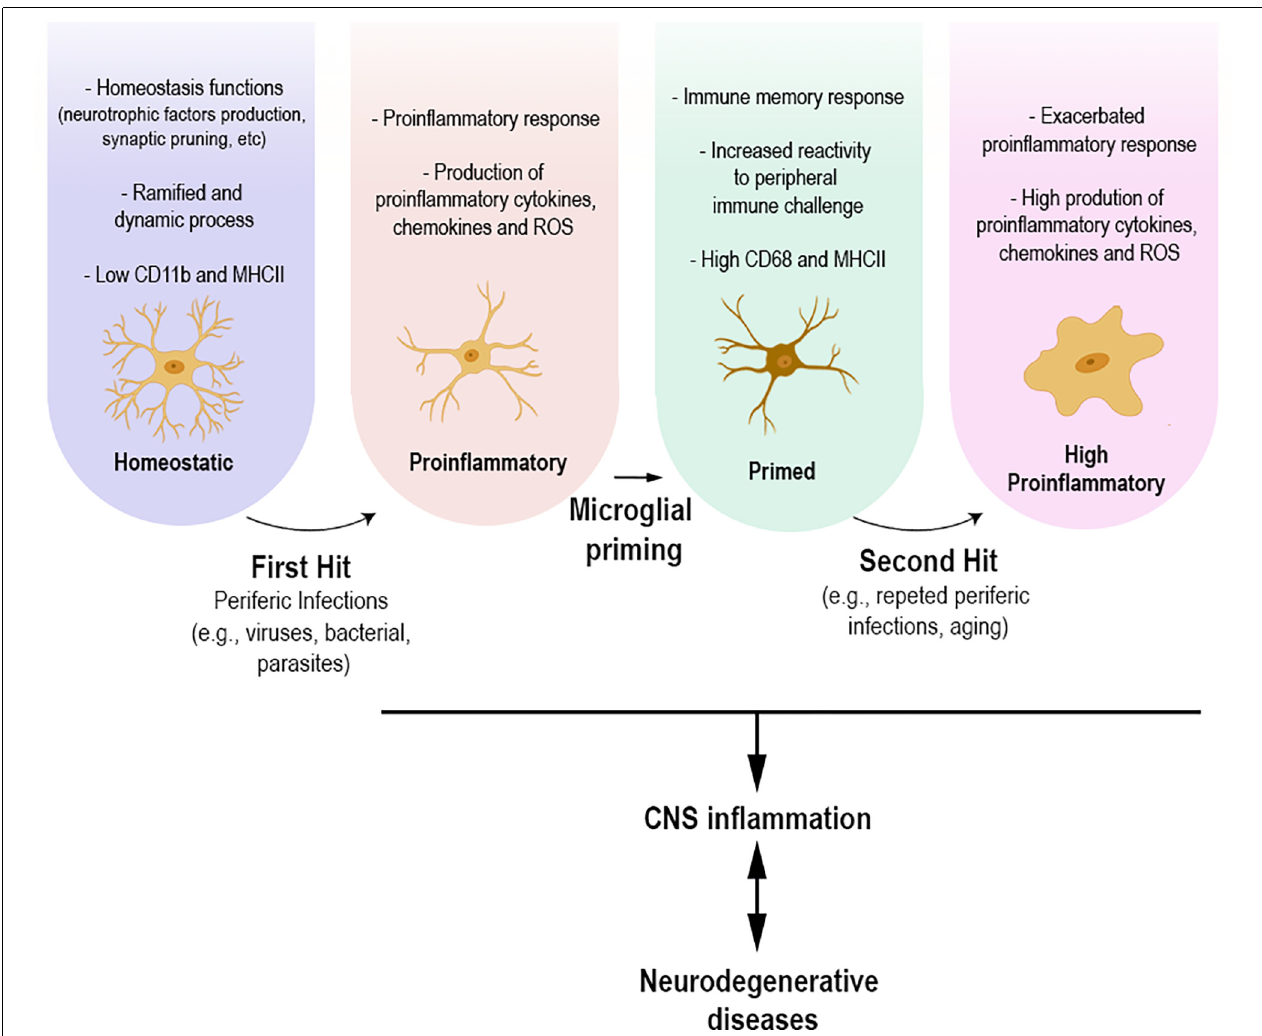
FIGURE 1 | Under physiological conditions, homeostatic microglial cells participate in various homeostasis functions, production of neurotrophic factors, and synaptic pruning. Their morphology presents ramified and dynamic cellular processes with high motility. Homeostatic microglia express low levels of CD11b and MHCII. Infections that occur throughout life, whether caused by viruses, parasites, or bacteria, can lead to microglial morphological and functional changes towards a proinflammatory state. The proinflammatory response leads to functional and morphological changes, including the upregulation of specific molecules and increased production of proinflammatory mediators, including cytokines, chemokines, and reactive oxygen species. Microglial cells present a branch architecture with thicker processes. This process can result in microglial priming, making these cells more responsive to an upcoming insult, causing an, even more, exacerbated inflammatory response. The different states of microglia are directly related to the inflammation process, which in turn might be related to the development of neurodegenerative